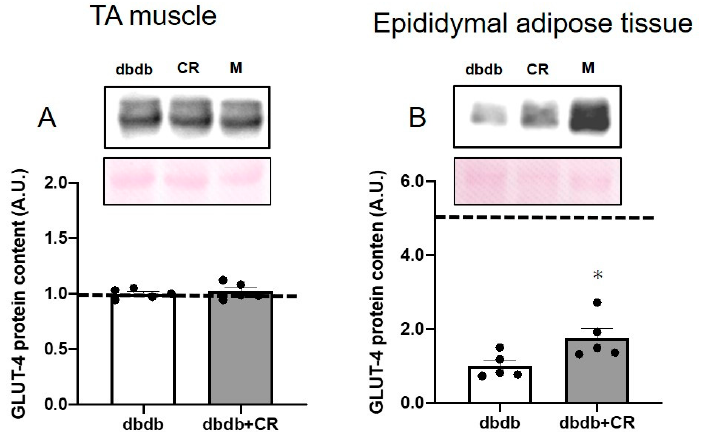
Figure 3. Effects of calorie restriction on GLUT-4 levels in db/db mice. GLUT-4 protein levels in mouse TA (tibialis anterior) muscle ( A ) and epididymal adipose tissue ( B ). dbdb, ad libitum-fed control group; dbdb+CR, daily calorie restriction group. Data of misty mice were used as reference values (dotted lines). Data are the mean ± SEM ( n = 5). * p < 0.05 compared with the dbdb group.